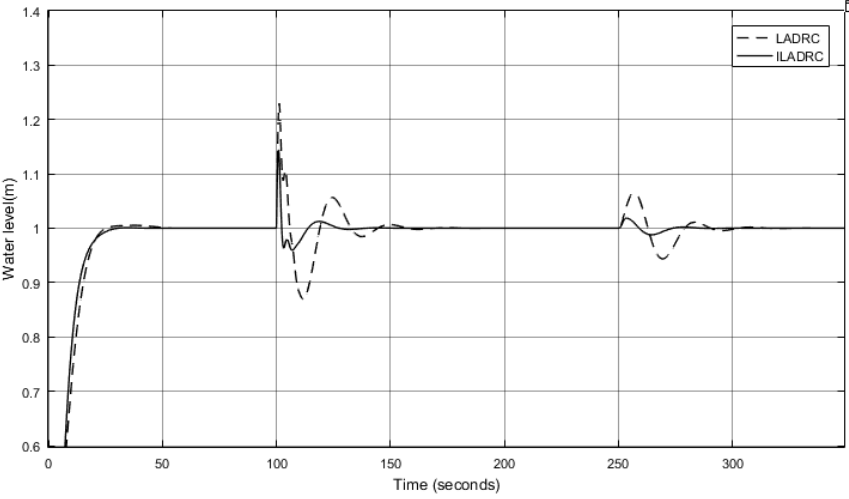
Figure 4. Comparison of LADRC and ILADRC anti-interference performance.